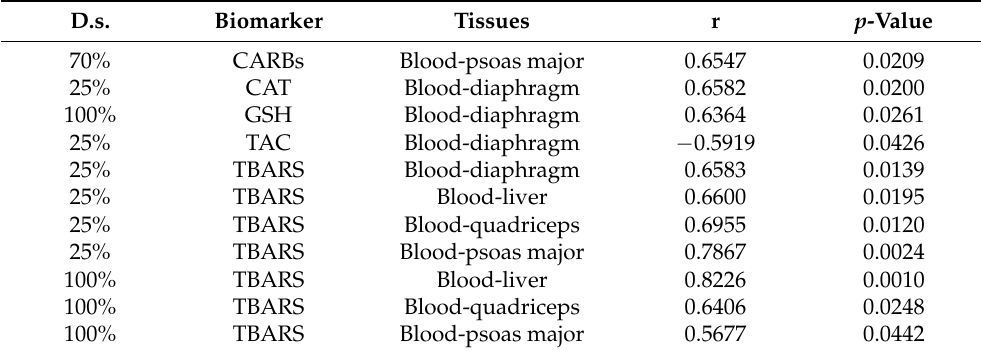
Table 1. Linear regression analyses between redox biomarkers in kids’ blood and the other 4 tissues tested (liver, diaphragm, quadriceps, psoas major) at the same d.s. ( p < 0.05, r > 0.5). D.s.